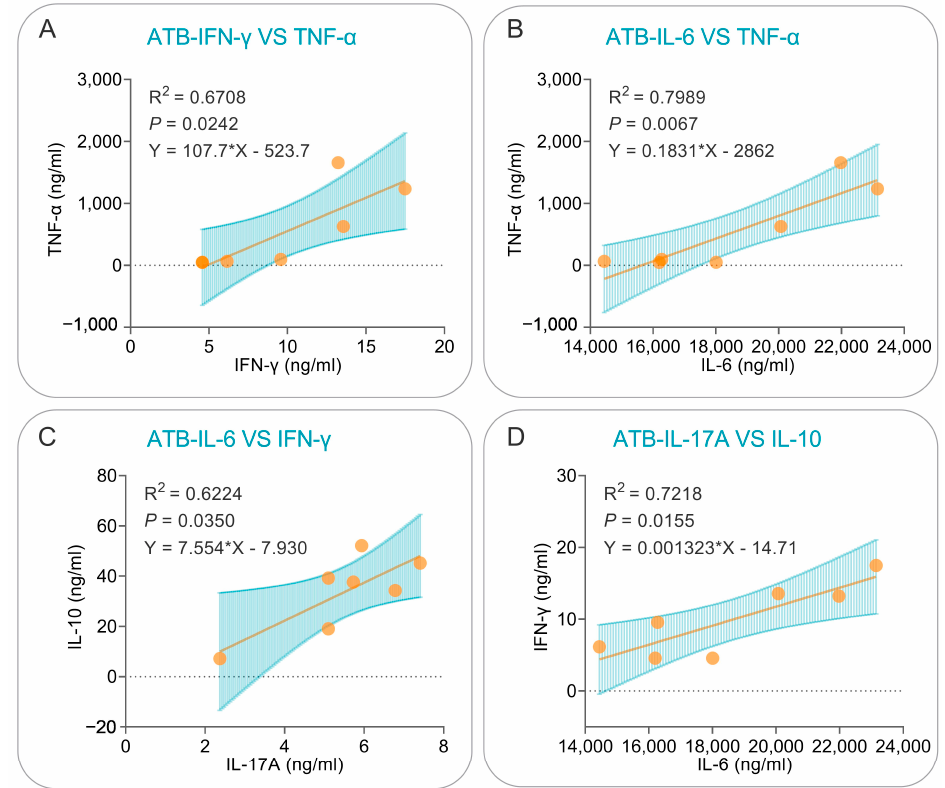
Figure 13. Simple linear regression analysis of cytokines in the ATB population. Correlations for IFN- γ vs. TNF- α ( A ), IL-6 vs. TNF- α ( B ), IL-6 vs. IFN- γ ( C ), and IL-17A vs. IL-10 ( D ) were analyzed using simple linear regression in GraphPad Prism 9.5.1 software. The R-squared values for the goodness of fi t, p values, and equations are shown in each panel. A p value lower than 0.05 was considered signi fi cant.